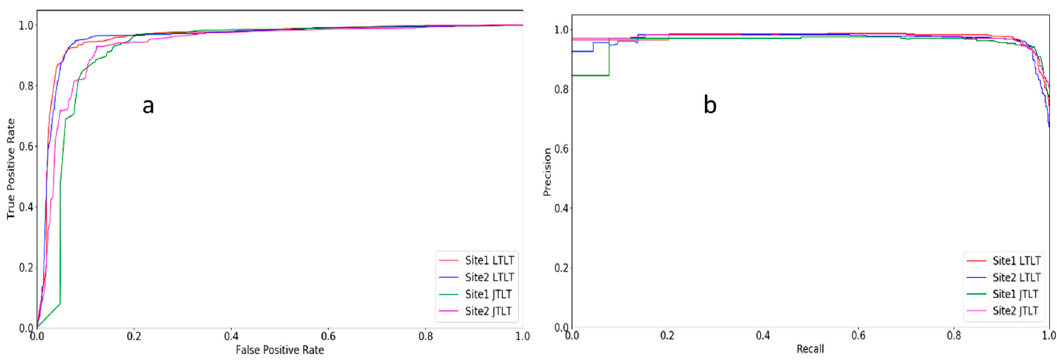
Figure 5. Receiver operating characteristic (ROC) curves ( a ) and positive rate (PR) plots ( b ) based on testing data for each site.